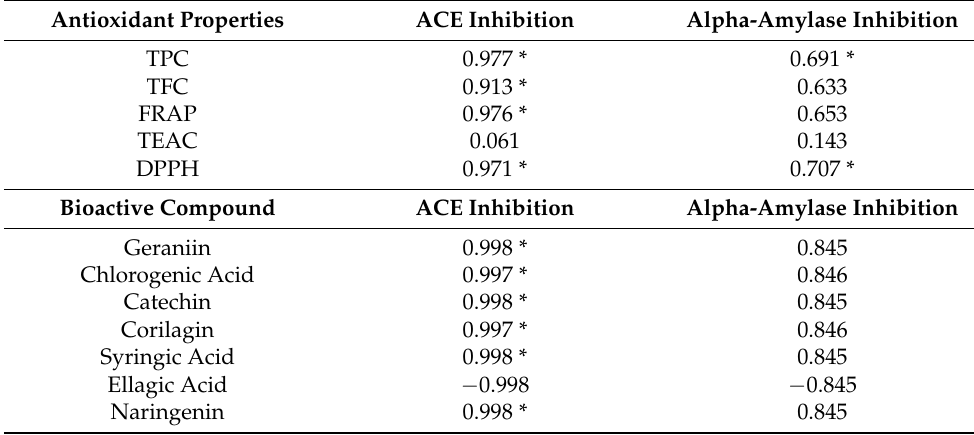
Table 4. Correlations between the studied